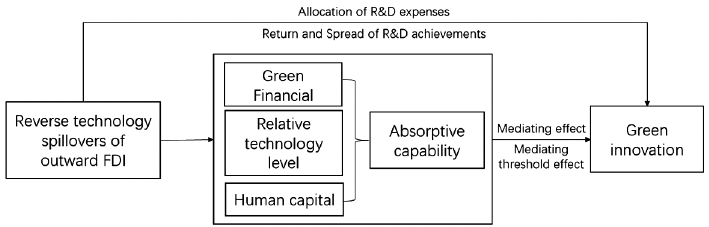
Figure 1. The influence mechanism of reverse green technology spillovers of outward